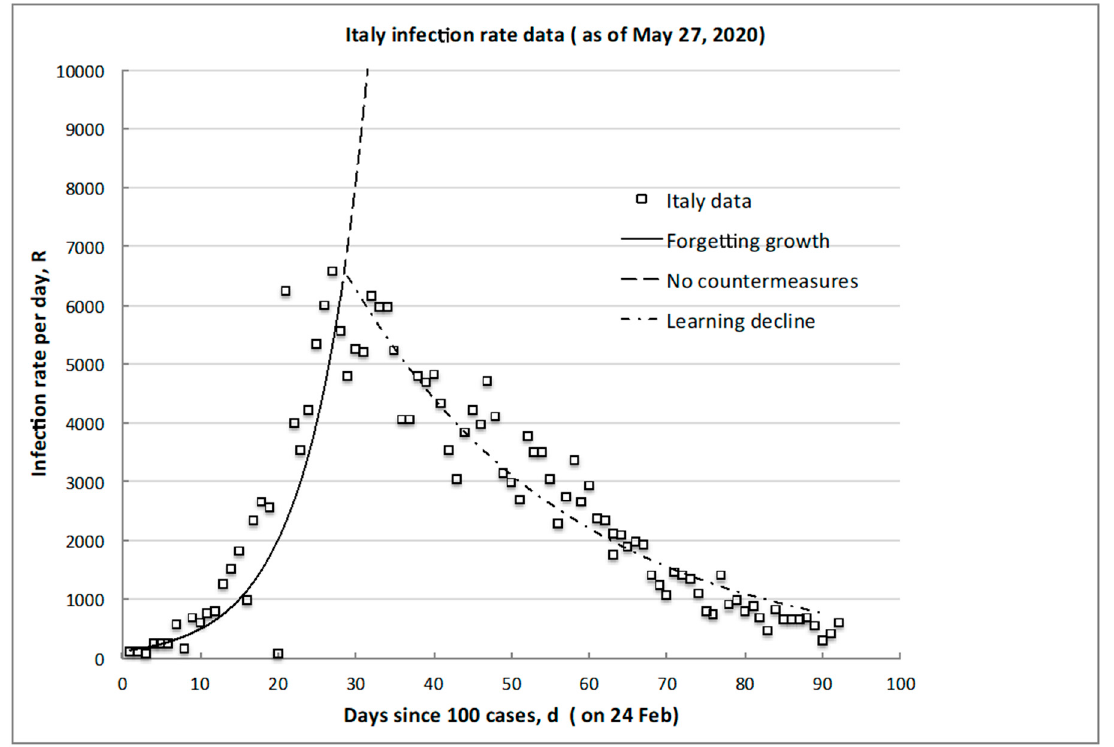
Figure 1. Typical infection rate trend illustrating the initial growth of the peak, R M , and desired decline to some attainable minimum, R m (CoVid-19 data for